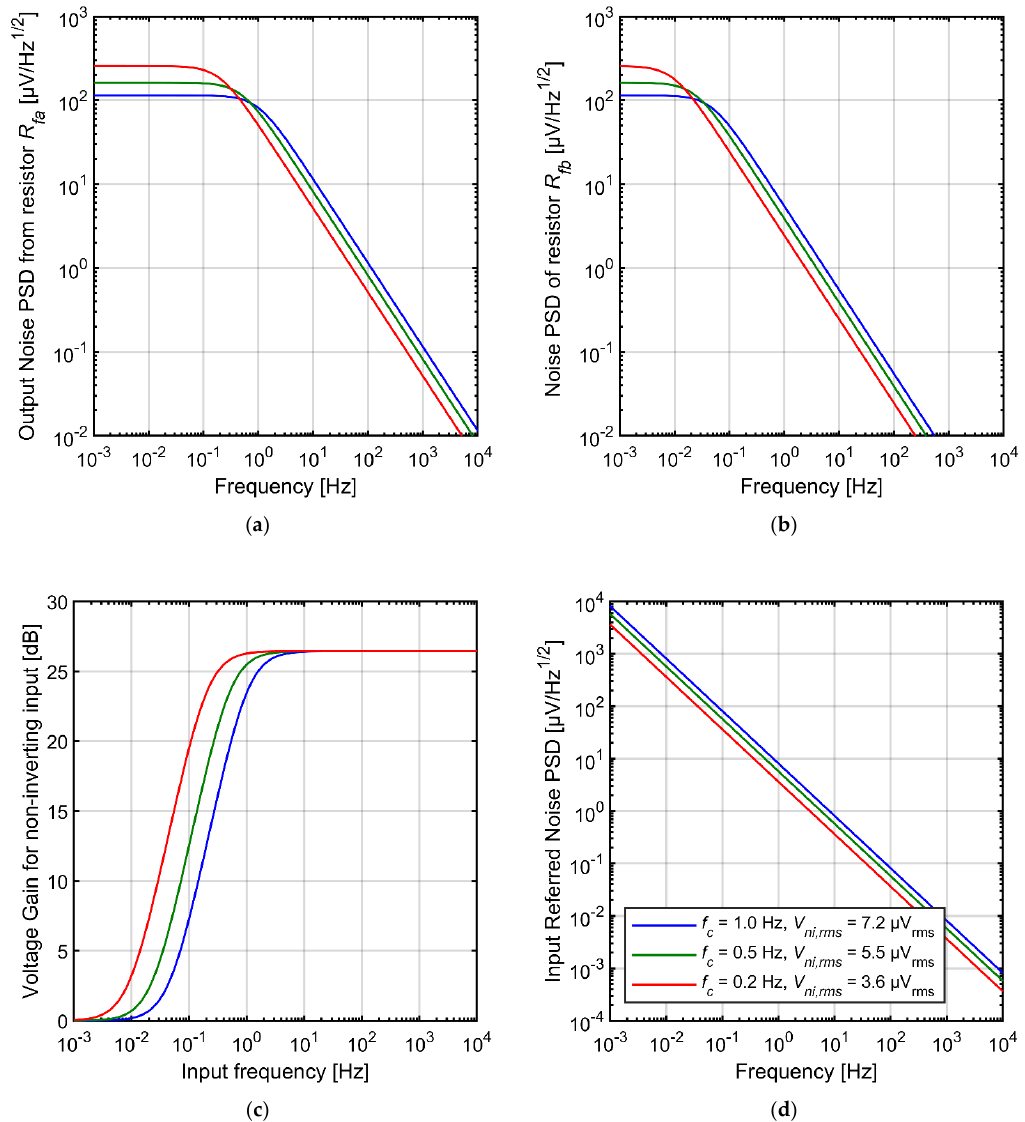
Figure 7. Characteristics of the AC-coupling circuit thermal noise for different settings of the AC-coupling circuit cutoff frequency ( a ) output noise PSD from resistor R fa ( b ) noise PSD of resistor R fb measured across this resistor ( c ) AC gain of the circuit with respect to non-inverting input of the operational amplifier ( d ) PSD of the combined input-referred noise from both resistors R fa and R fb .